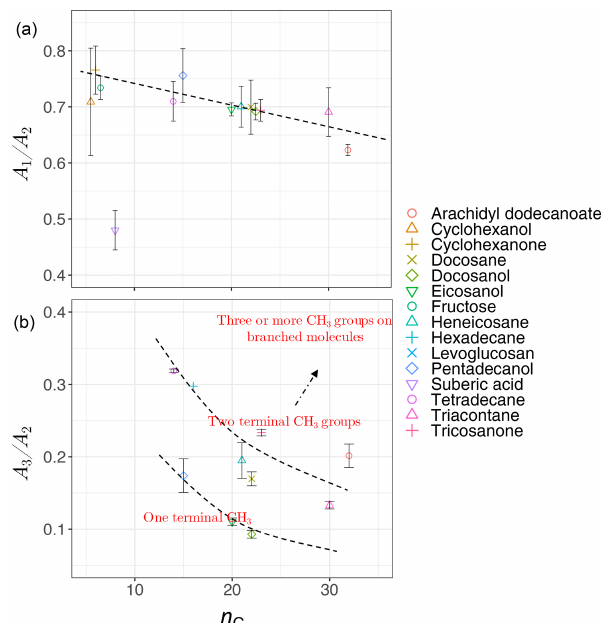
Figure 8. Scatter plots showing the relation between carbon num- ber ( n C ) and the ratio of peak heights of symmetric CH 2 to asym- metric CH 2 stretching ( A 1 /A 2 , a ), and the ratio of peak heights of asymmetric CH 3 stretching to asymmetric CH 2 stretching ( A 3 /A 2 , b ), averaged for each substance in laboratory standards. Error bars show ± 1 standard error from the average, and dashed lines are vi- sual guides for the trends and levels.